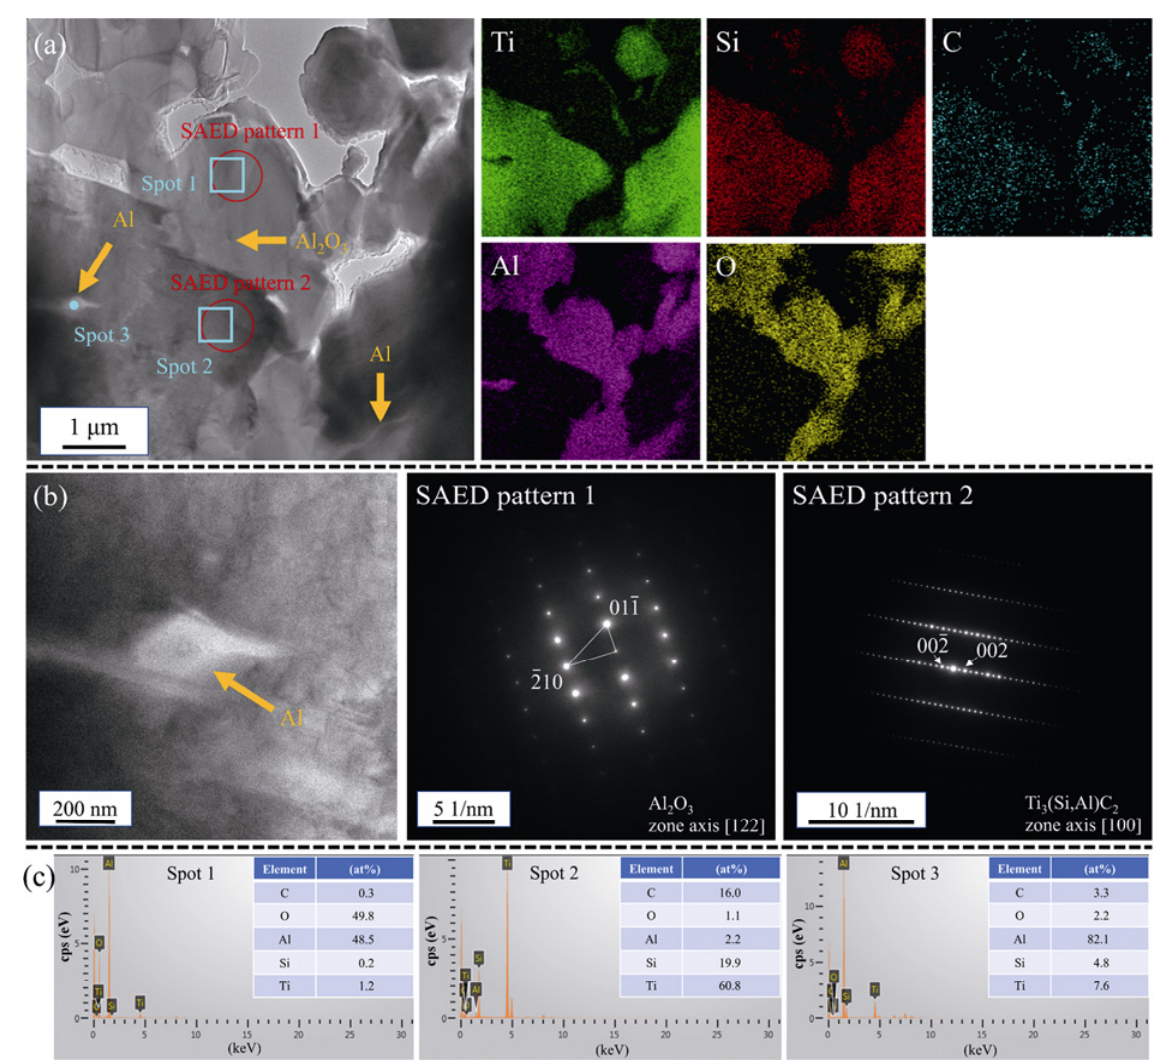
Fig. 8 TEM images of the sintered HP sample: (a) microstructure of the sintered composite and corresponding elemental distributions; (b) TEM image of Al and SAED patterns of Al 2 O 3 and Ti 3 (Si,Al)C 2 ; and (c) EDS point scan